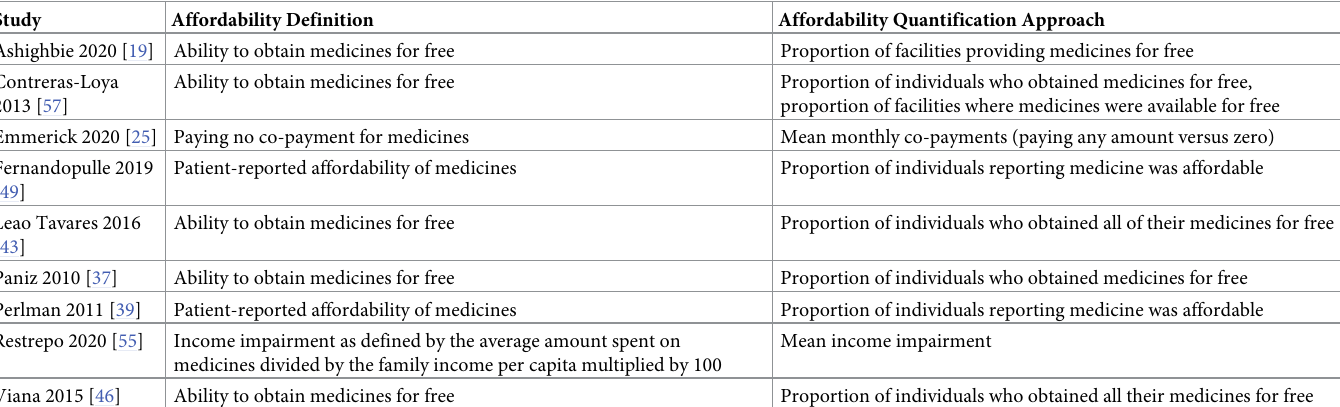
Table 4. Approaches to measuring affordability used by different